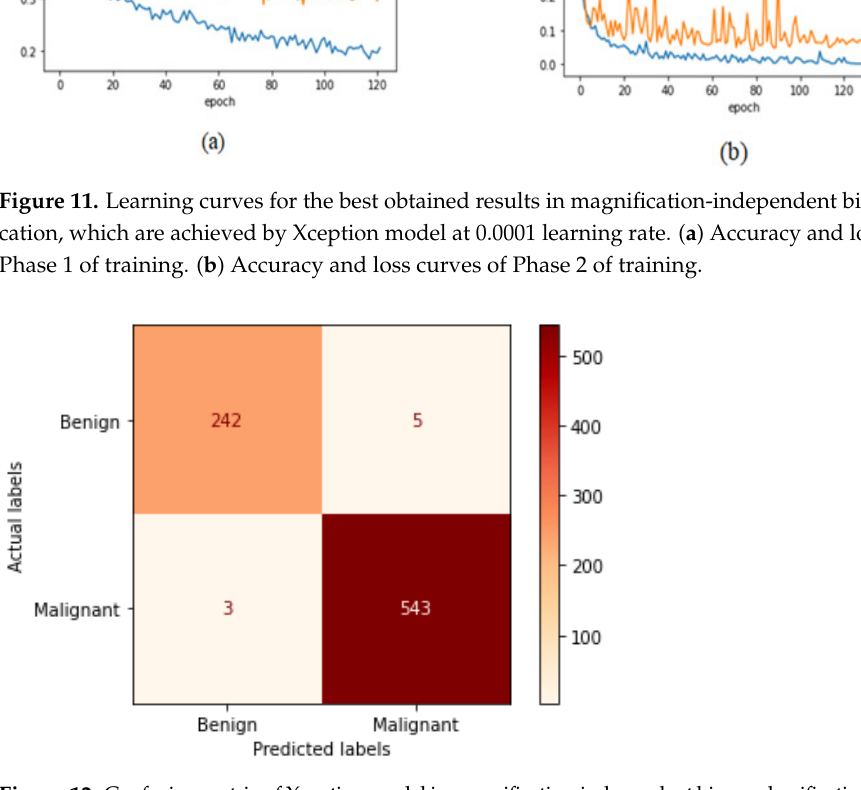
Figure 12. Confusion matrix of Xception model in magnification-independent binary classification experiment.